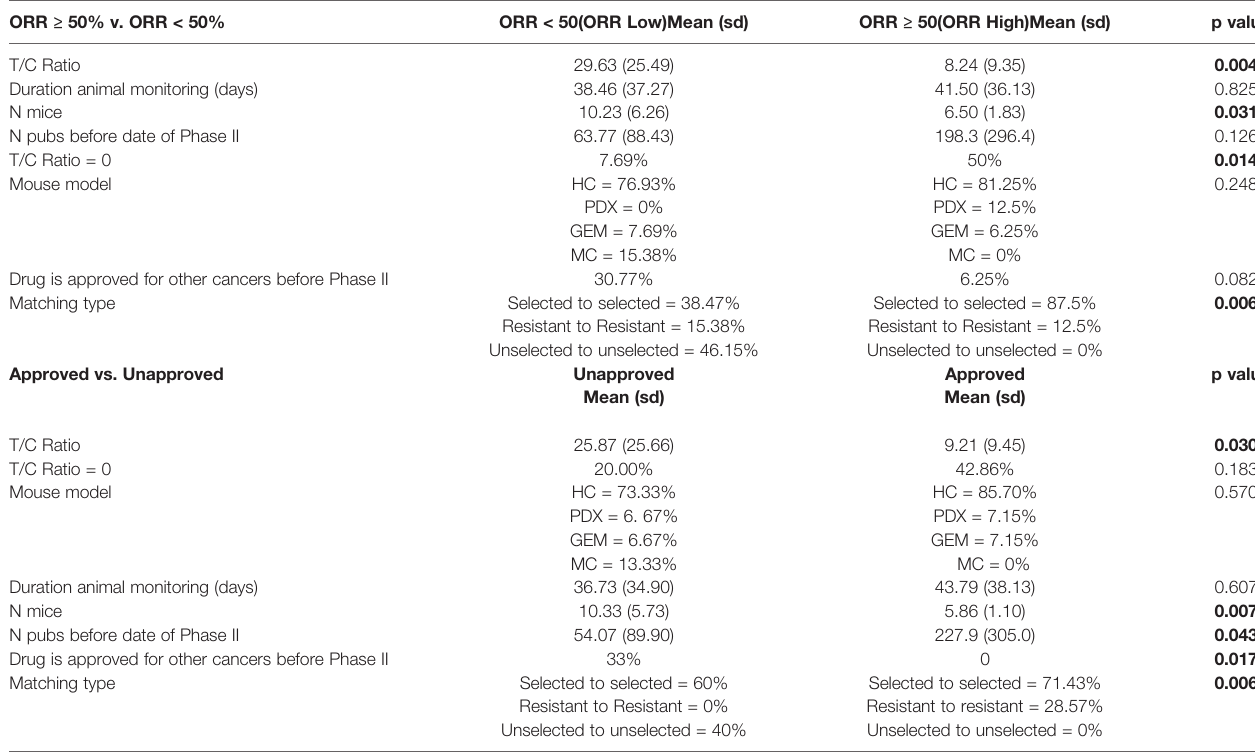
TABLE 3 | Preclinical metrics differ signi fi cantly between objective response rate (ORR) High and ORR Low drug-indication pairs as well as Approved and Unapproved drug-indication